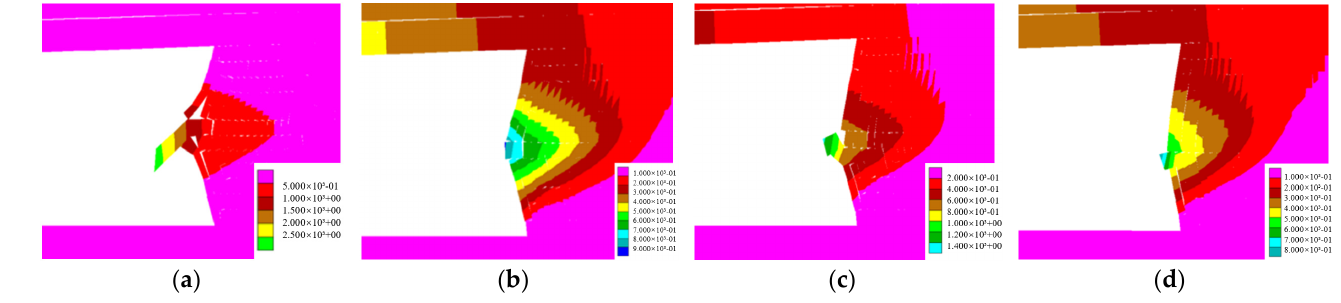
Figure 21. Displacement diagram of grouting hole reinforcement at different positions: ( a ) without shoring; ( b ) 1.5 m from the roof; ( c ) 2.0 m from the roof; ( d ) 1.5 and 3 m from the roof.